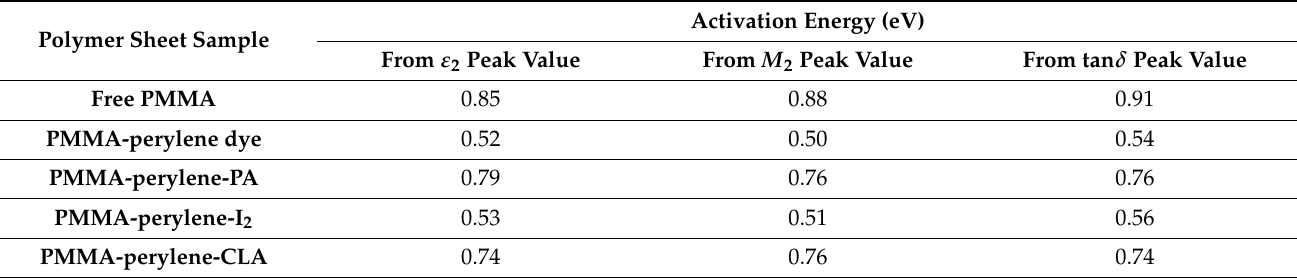
Table 2. Activation energy of the synthesized polymeric